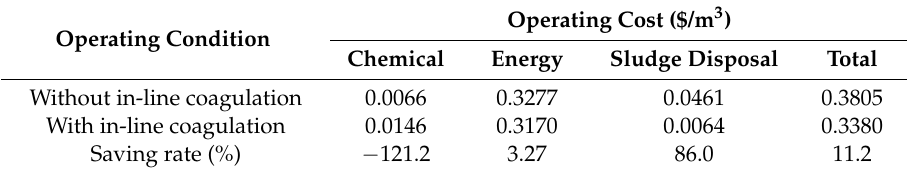
Table 3. Comparison of unit cost ($/m 3 ) between without and with in-line coagulation.